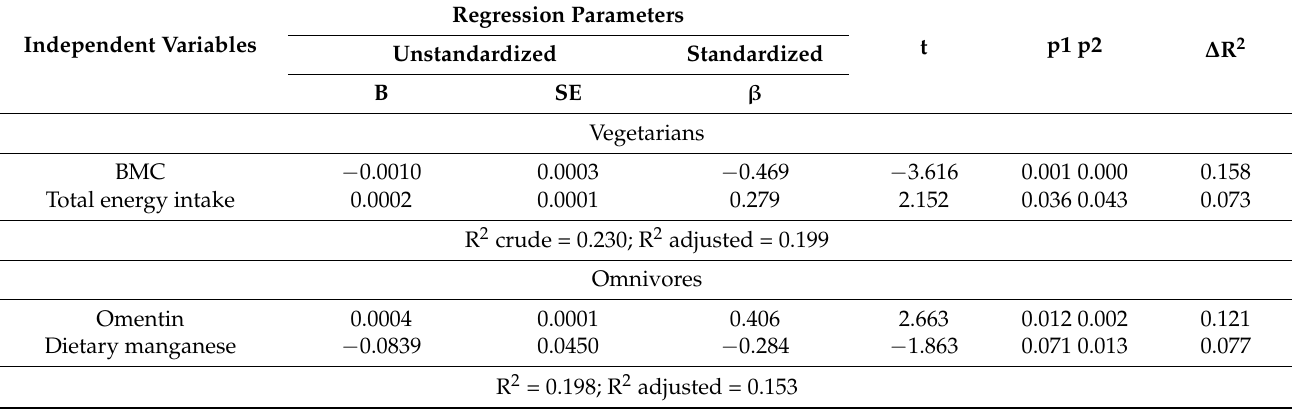
Table 6. Multivariate regressions of irisin with independent variables in the groups of vegetarians and omnivores.